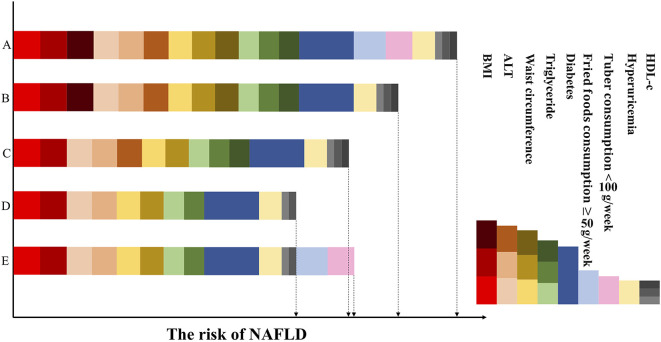
Dynamic risk score based on changes in obesity, dietary, clinical variables and related diseases. The figure represents the same patient over the intervention period. In the first column, row A represents the patient's score at which point he has unfavorable BMI and waist circumference, high serum triglyceride levels, low HDL-c levels, and impaired ALT levels, developed diabetes and hyperuricemia, and eats little tuber and a lot of fried foods. The risk decreases in row B, as consumption of tuber increased and restriction on fried foods (intervention strategy 1). Row C reflects the efforts of the patient to stay lean and maintain his waist circumference at <87 cm (intervention strategy 2): the risk score further decreases. Row D shows the patient has relatively normal serum HDL-c, triglyceride and ALT levels on account of the previous intervention strategies and has a low risk of NAFLD. While in the final one, row E, at which point his clinical characteristics are unchanged but he had bad dietary habits again. As a result, his risk score has increased and higher than row D. Red, brown, dark red means BMI: 20.5–22.4, 22.4–24.6, and >24.6 kg/m; Peach puff, sandy brown, chocolate means serum ALT: 13–18, 18–26, and >26 IU/L; Gold, goldenrod, dark khaki means waist circumference: 74–80, 80–87, and >87 cm; Light green, green, dark green means triglyceride: 0.88–1.15, 1.15–1.62, and >1.62 mmol/L; Dark blue means the presence of diabetes; Light blue means the consumption of fried foods ≥50 g/weeks; Pink means the consumption of tuber <100 g/weeks; Wheat means the presence of hyperuricemia; Light gray, gray, dark gray means HDL-c: 1.36–1.46, 1.17–1.36m and <1.17 mmol/L.